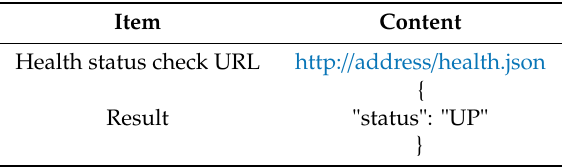
Table 3. URL of health check interface and check